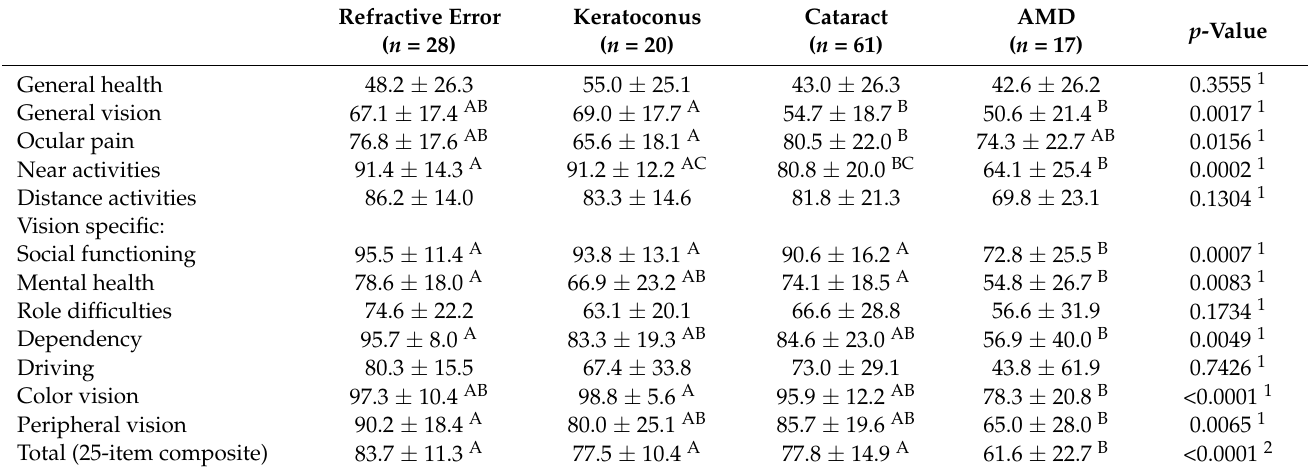
Table 2. NEI-VFQ-25 subscale scores and composite score ( n =